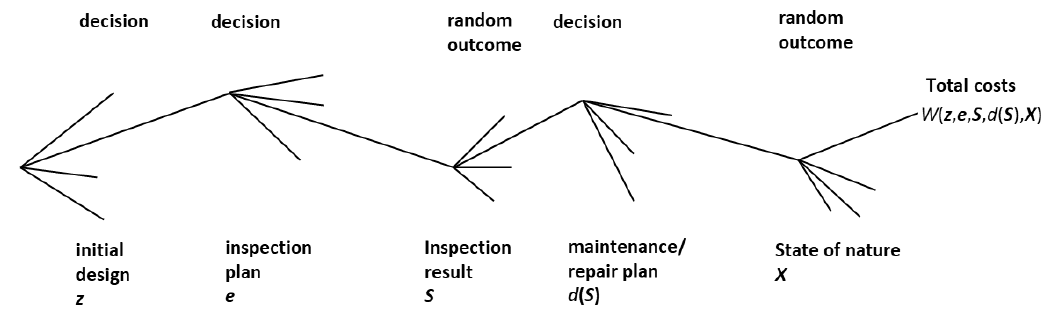
Figure 2. Generic decision tree for operation and maintenance (O&M) decision-making [5].